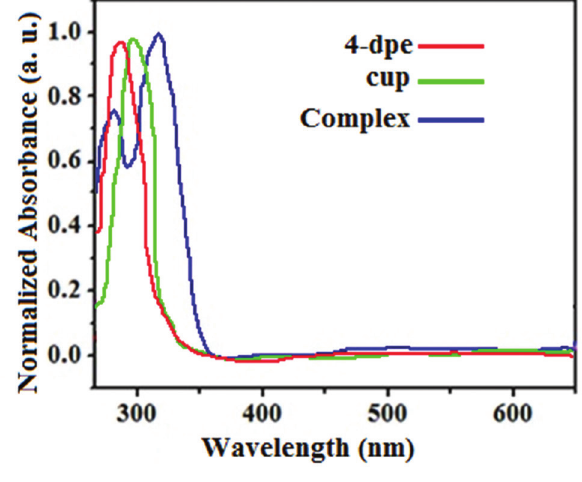
Figure 6: Absorption spectra of the bare ligands and tin complex in the solid state.